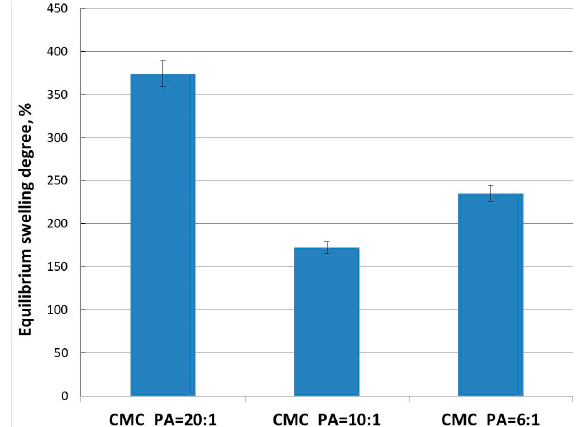
Figure 3. Equilibrium degree of swelling of the hydrogels at different CMC/PA molar ratios.